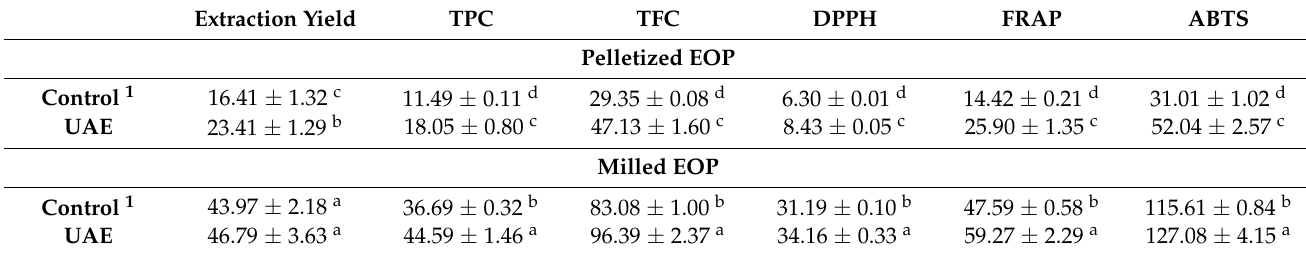
Table 2. Comparison of the application of milling and ultrasound in the extraction of exhausted olive pomace (EOP): Extraction yield (%), total phenolic content (TPC) (mg gallic acid equivalents/g EOP), total flavonoid content (TFC) (mg rutin equivalents/g EOP), and antioxidant activity (DPPH, FRAP, and ABTS) (mg Trolox equivalents/g EOP). Data represent the average value and standard deviation (n ≥